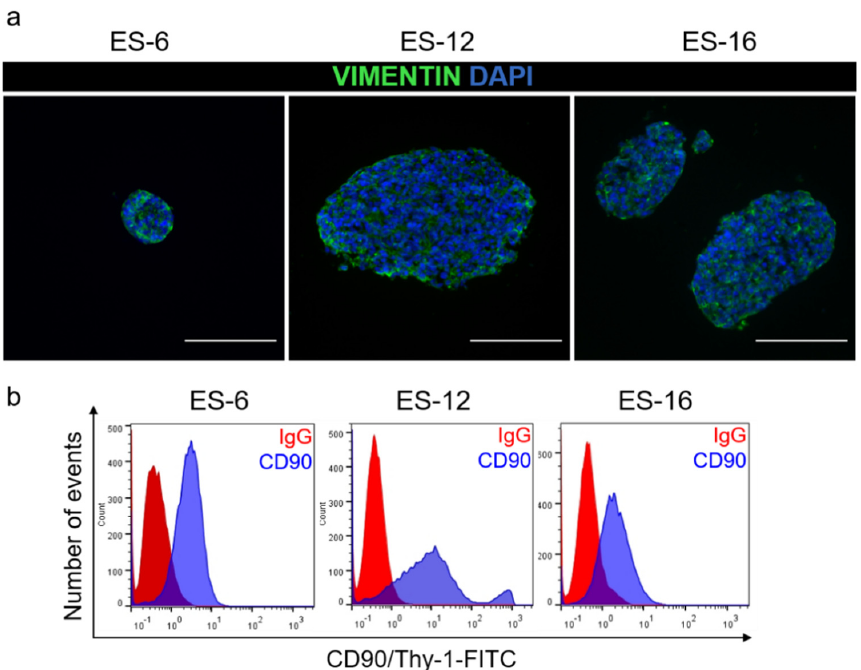
Figure 3. Phenotypic characterization of ES cells after three weeks of encapsulated spheroid culture. ( a ) Immunofluorescence detection of vimentin (green) in encapsulated spheroids generated from three distinct ES-PDX; nuclei were counterstained with DAPI (blue). Scale bar: 100 μ m. ( b ) Flow cytometry detection of CD90/Thy-1 (blue) on ES cells retrieved from encapsulated spheroid cultures generated from three distinct ES-PDX. IgG isotype control represented in red.